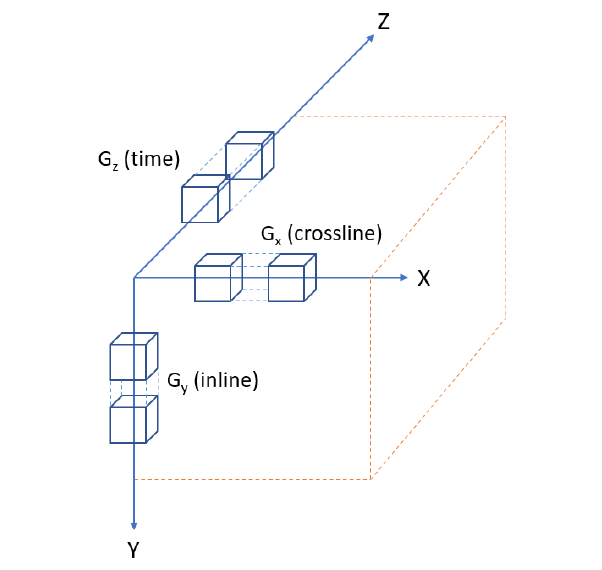
Figure 3. Illustration of 3D Sobel filtering. The x , y , and z axes correspond to the crossline, inline, and time axes of a grayscale video sequence,